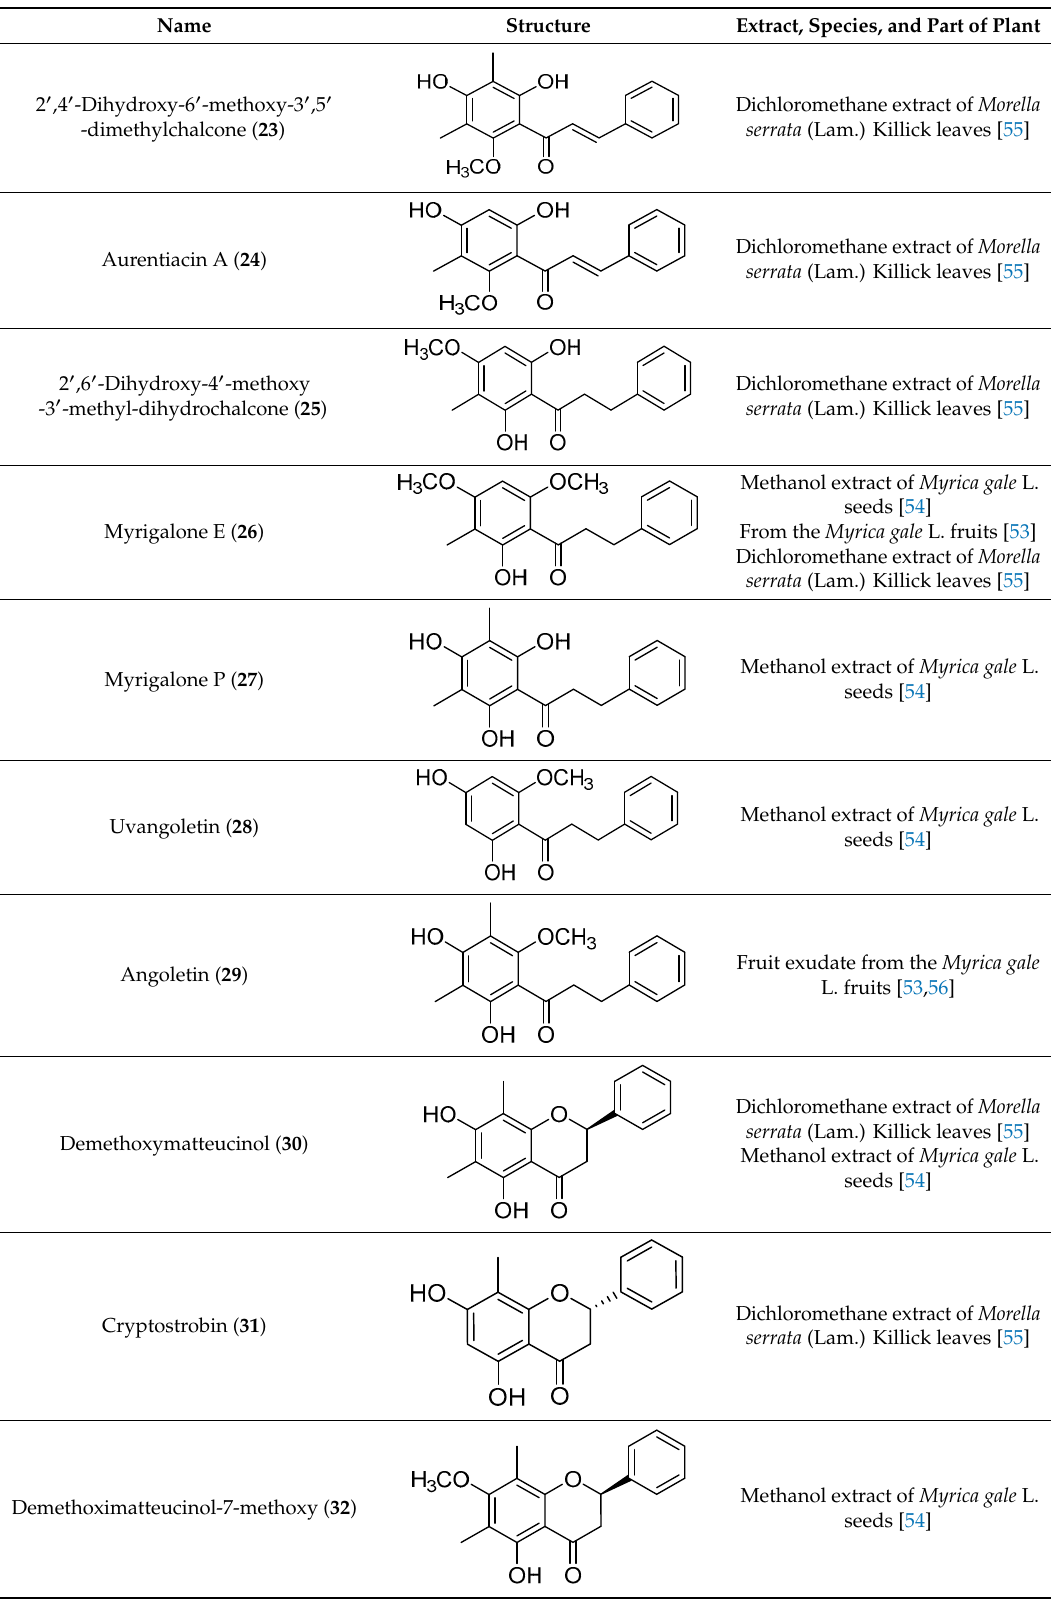
Table 3. Other secondary metabolites isolated from Morella / Myrica genera.